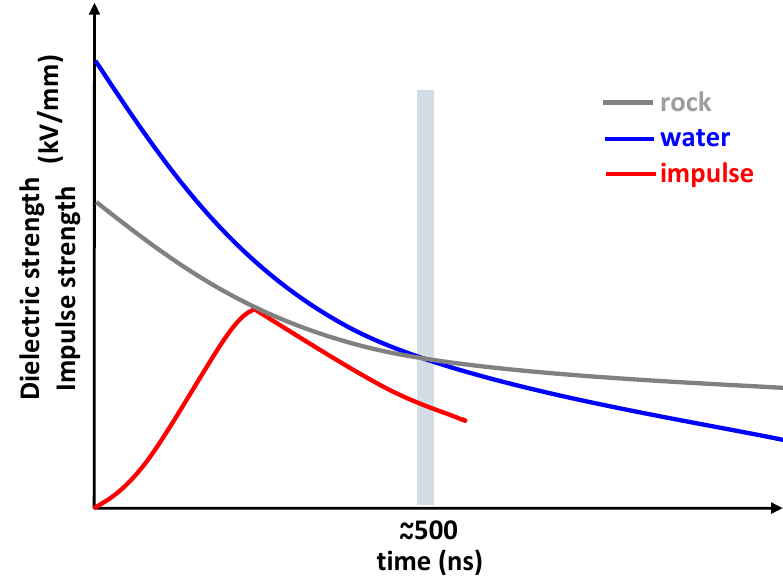
Figure 6. Variation of dielectric strength with the pulse rise time.